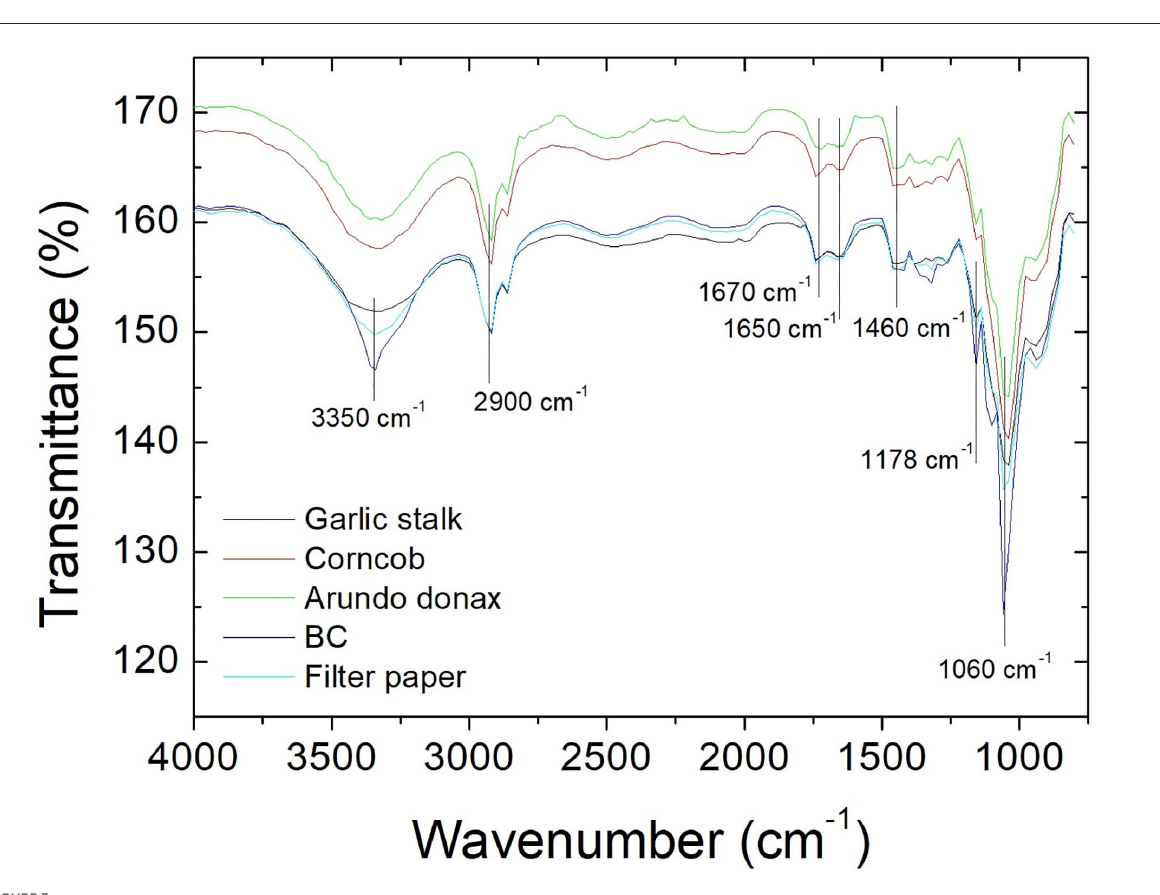
A preliminary morphological assessment of the cellulose extracted from garlic stalk, corncob, and giant cane cut-up was performed by optical microscopy analysis (Figure 5). Cellulose from all three lignocellulosic wastes was represented by a fibrous morphology, as confirmed by previous similar works (Luan et al., 2012; Vanderghem et al., 2012; Arantes et al., 2017; Wu and Cheng, 2017). Moreover, the overall length of the cellulose fibers was up to 1mm, with a width varying from ∼ 10 to ∼ 15 µ